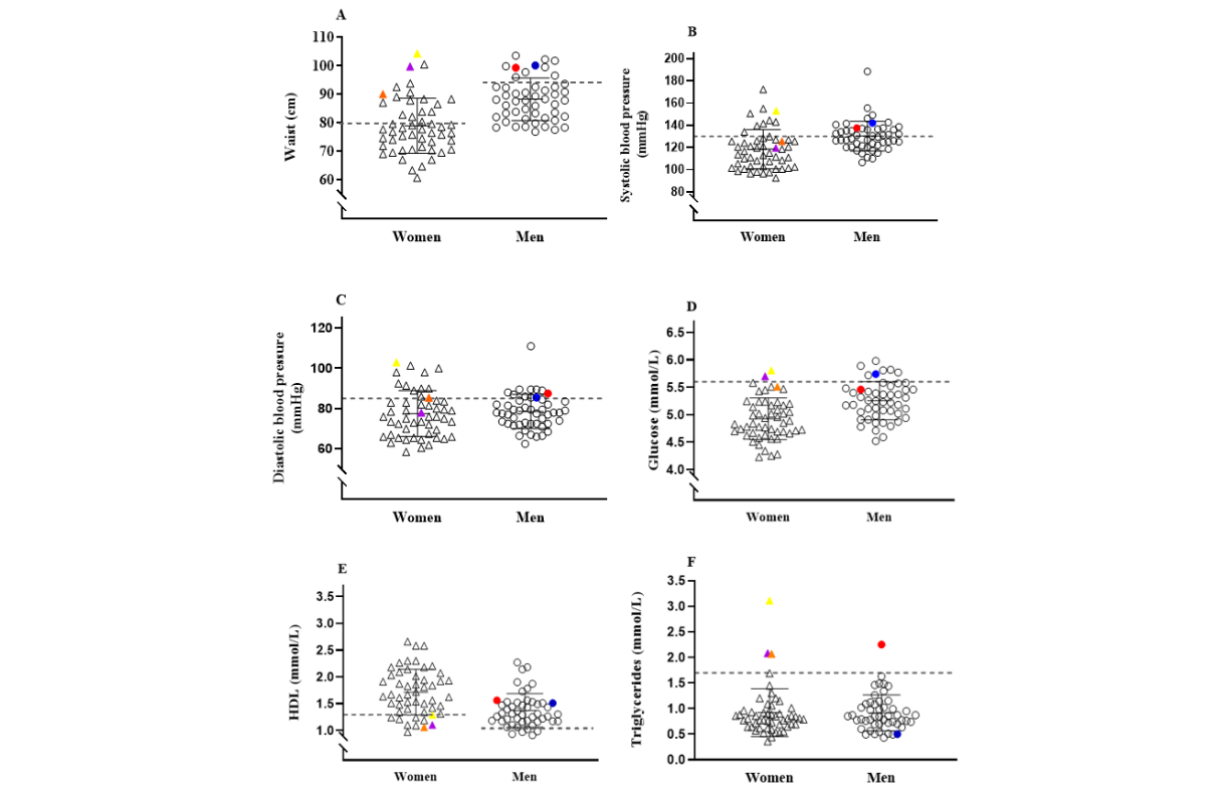
Figure 2. Health profile in relation to metabolic syndrome variables. The triangles represent women, and the circles represent men. Three women (yellow, orange, and purple triangles) and two men (red and blue circles) fulfilled the criteria for metabolic syndrome. The solid lines represent the mean (SD) for each group. The dashed lines represent the cut-off criteria (values mentioned in the brackets that follow) for each variable in accordance with the definition provided by the International Diabetes Federation. A: Waist circumference in females ( ≥ 80 cm) and males ( ≥ 94 cm); B: Systolic blood pressure ( ≥ 130 mm Hg); C: Diastolic blood pressure ( ≥ 85 mm Hg); D: Fasting plasma glucose ( ≥ 5.6 mmol/L); E: High-density lipoprotein (HDL) for females ( 1.29 mmol/L) and males ( 1.03 mmol/L); F: Triglycerides ( ≥ 1.7